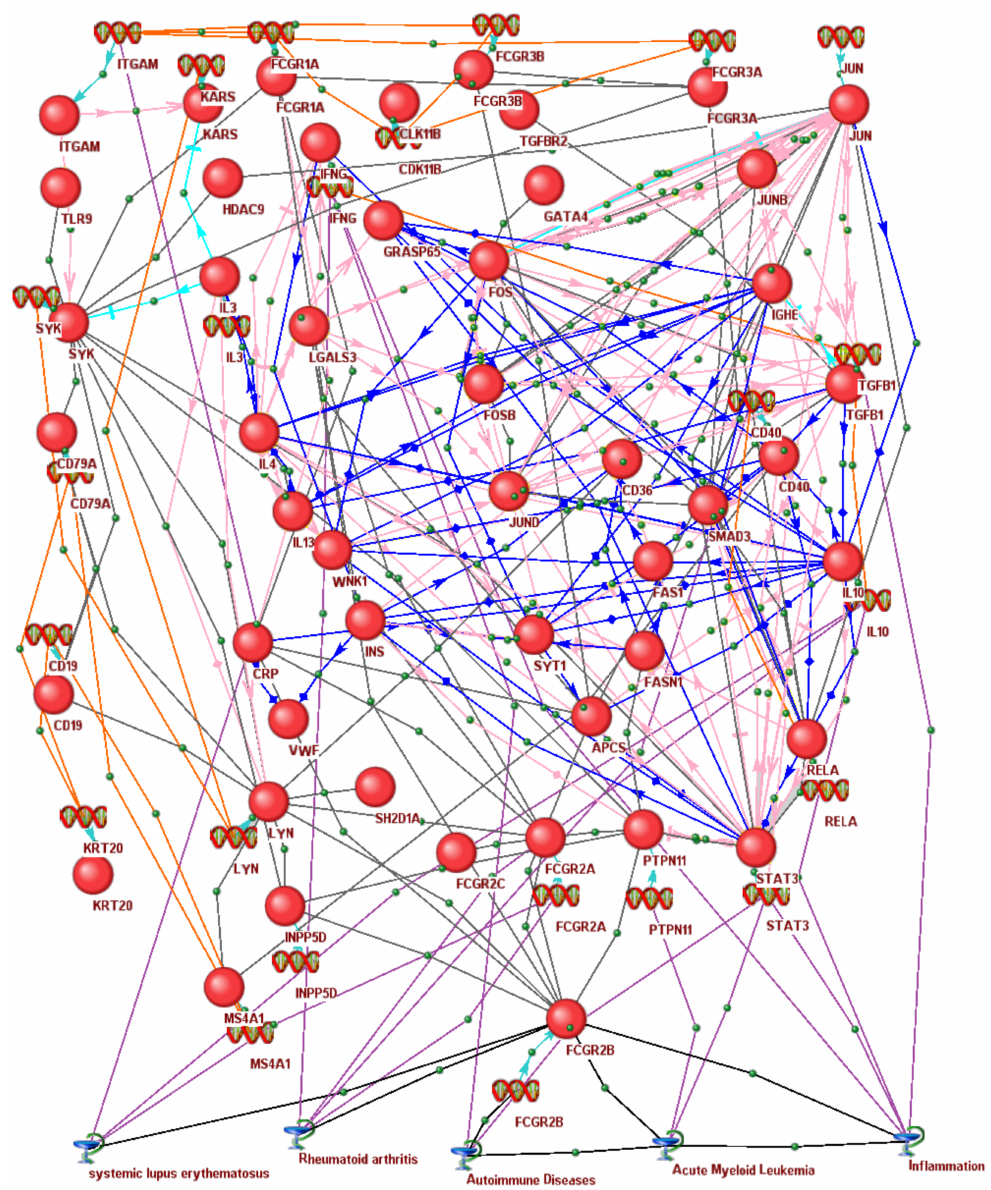
Figure 5. The FCGR2B -related associative gene network as a data-mining summary of molecular genetic research articles and databases. The network was built using the automated mode of our publicly available web service ANDSystem [227] with “Human, FCGR2B, gene, protein” as input. Legend: Nodes: red circles, proteins; icons “double DNA helix”, genes; “Bowl of Hygieia” symbols, diseases. Edges: turquoise sharp and blunt arrows, expression and degradation, respectively; pink sharp and blunt arrows, up- and downregulation, respectively; blue arrows, transport regulation; purple, orange, and black lines: involvement, coexpression, and association, respectively. CRP and APCS, pentraxin 1 and 2, respectively; CD19, CD36, CD40, and CD79A, proteins CD19, CD36, CD40, and CD79a, respectively; CDK11B, cyclin-dependent kinase 11B; CRP, C-reactive protein; FAS, Fas cell surface death receptor; FASN, fatty acid synthase; FCGR1A, FCGR2A, FCGR2C, FCGR3A, and FCGR3B, Fc γ receptors Ia, IIa, IIc, IIIa, and IIIb, respectively; FOS, FOSB, JUN, JUNB, and JUND, transcription factor AP-1 subunits Fos, FosB, Jun, JunB, and JunD, respectively; GATA4, GATA- binding protein 4; GRASP65, Golgi reassembly-stacking protein 1; HDAC9, histone deacetylase 9; IFNG, interferon γ ; IL3, IL4, IL10, and IL13, interleukins 3, 4, 10, and 13, respectively;